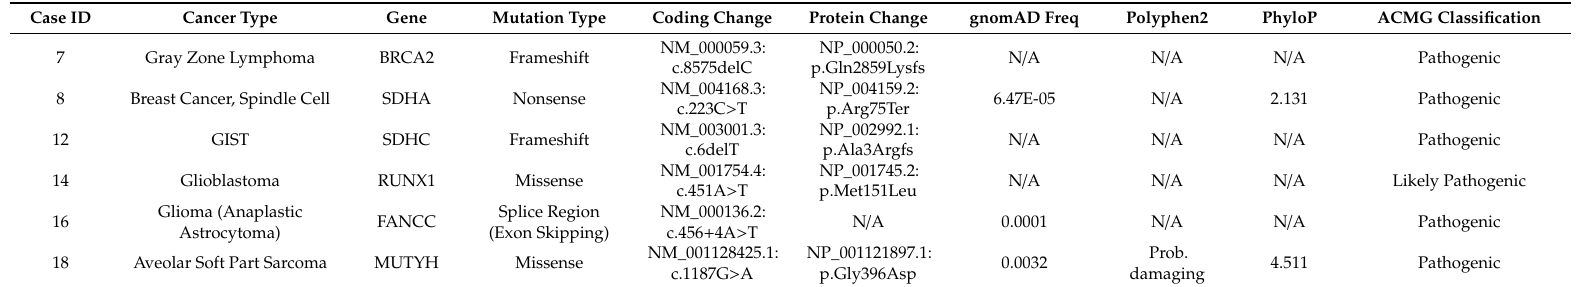
Table 2. ACMG classified pathogenic / likely pathogenic variants